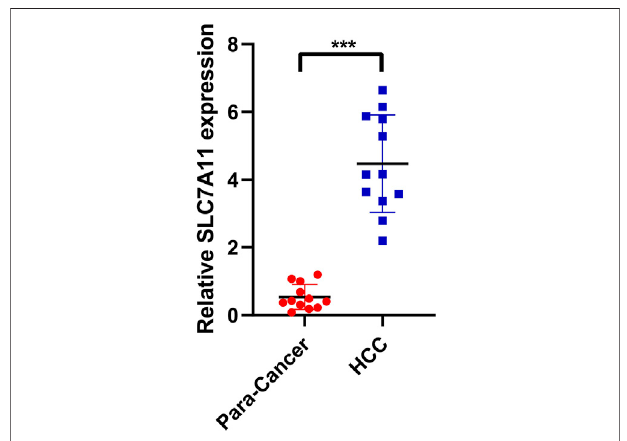
FIGURE9| PCR wasperformed toverify the expression ofthe keygene SLC7A11. SLC7A11 was signi fi cantly overexpressed in HCC compared with adjacent normal